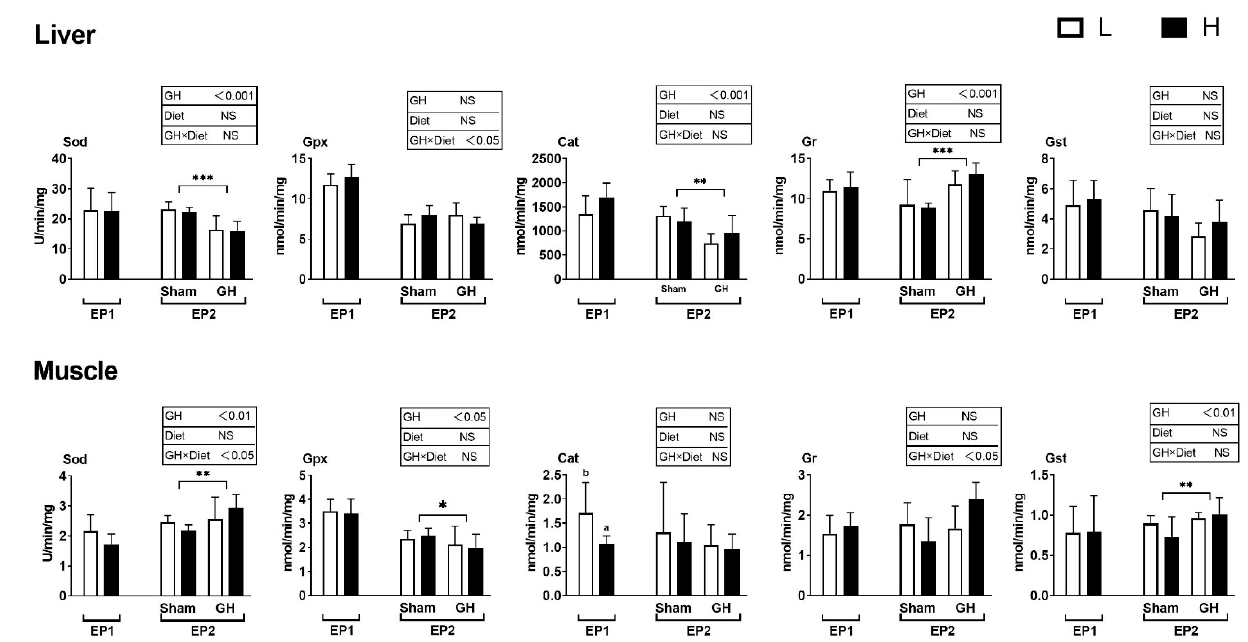
Figure 6. Changes in specific antioxidant enzyme activity in response to dietary vitamins and GH implantation or shame implantation over EP1 and EP2. Data presented as means ± SD. P -values obtained from two-way ANOVA on the main effects of diet, GH, and interaction are provided in insets. *, **, ***; significant effect of treatment ( p ≤ 0.05, p ≤ 0.01, p ≤ 0.001, two-way ANOVA). Different l letters denote significant effect between groups in the EP1, small letters are the result of post-hoc after significant interactions (two-way ANOVA with Tukey HSD post-hoc) in the EP2.